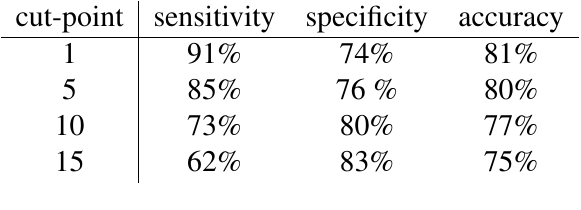
Figure 3: Plot of chi-square values at each trinucleotide position for part of the Saccharomyces cerevisiae chromosome I DNA sequence. The thick red lines highlight the positions corresponding to coding regions. Table 4: Sensibility, specificity and accuracy mean values for four cut-point values over all used files, using the adjusted